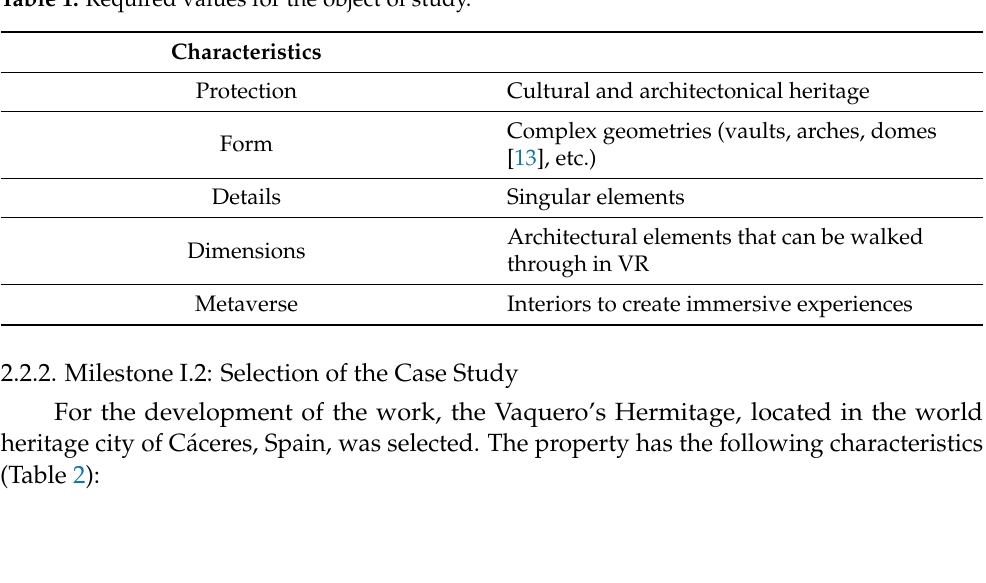
Table 1. Required values for the object of